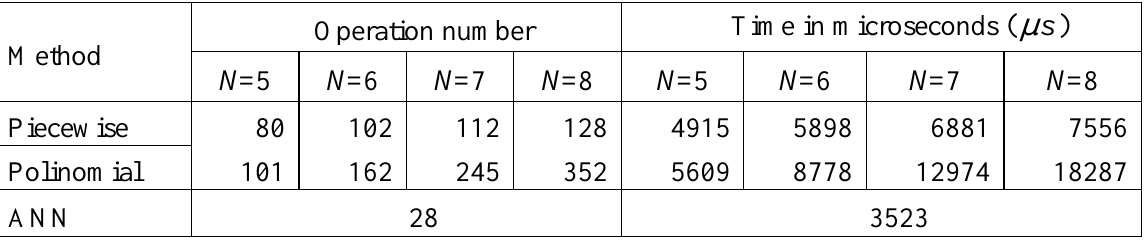
Table 2. Autocalibration methods. Their number of operations required and their computation